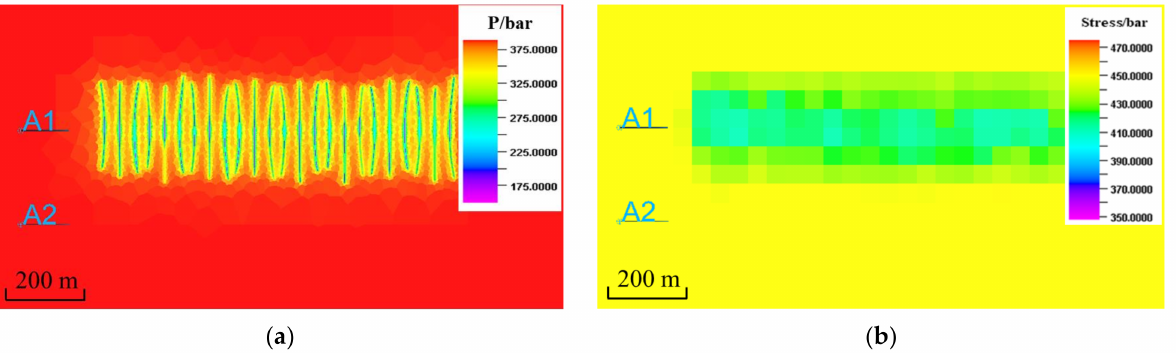
Figure 4. Distribution of ( a ) pressure; ( b )